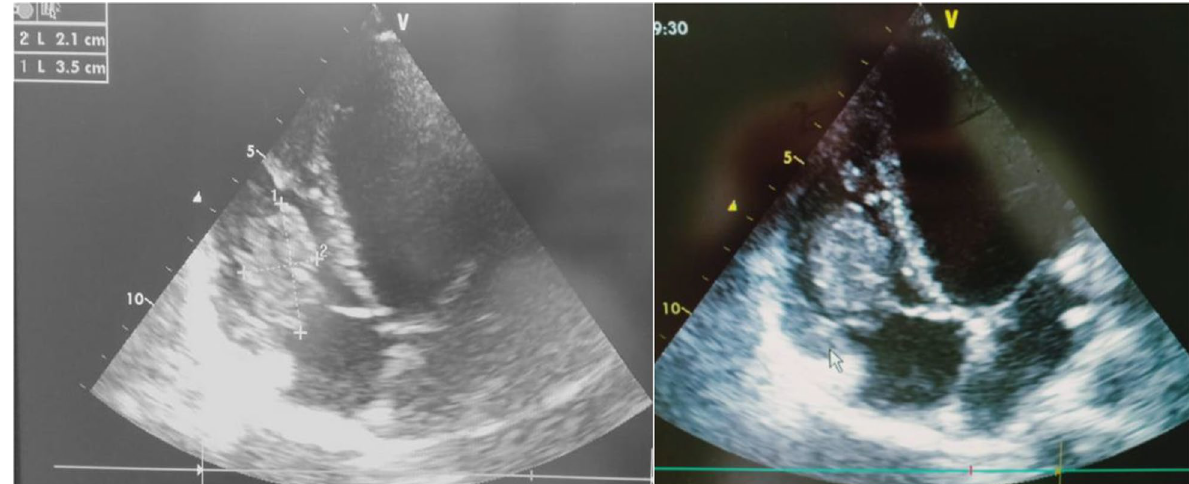
Fig. 1 Transthoracic echocardiography: 4-chamber view showing a right ventricle mass attached to the anterior cusp of the tricuspid valve